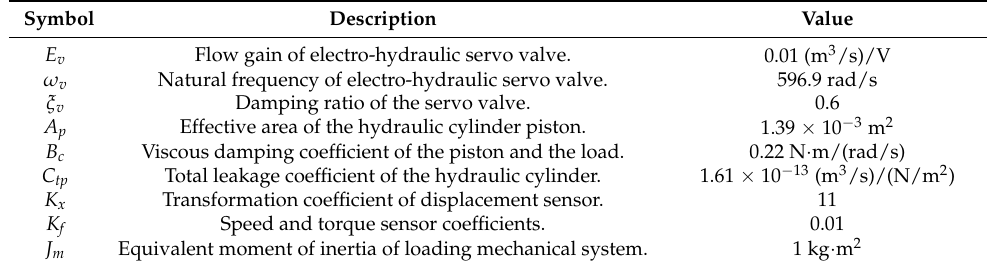
Table 3. Main parameters for simulation model. Symbol Description Value E v Flow gain of electro-hydraulic servo valve. 0.01 (m 3 /s)/V ω v Natural frequency of electro-hydraulic servo valve. 596.9 rad/s ξ v Damping ratio of the servo valve. 0.6 A p Effective area of the hydraulic cylinder piston. 1.39 × 10 − 3 m 2 Viscous damping coefficient of the piston and the load. Transformation coefficient of displacement sensor. 11 K f Speed and torque sensor coefficients. 0.01 J